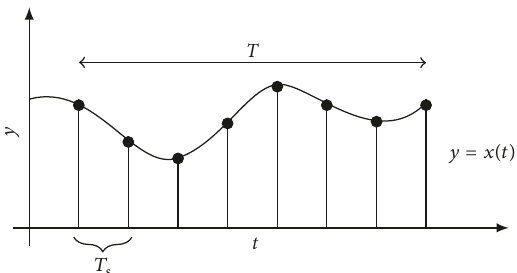
Figure 18: Common band limited and real-valued function. The reference sampling points are equally spaced with the distance 𝑇 s